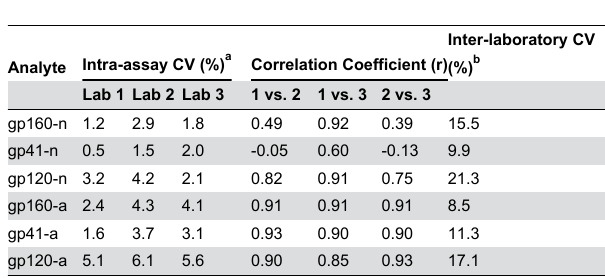
Table 2. Intra-assay and inter-laboratory performance of prototype kit.